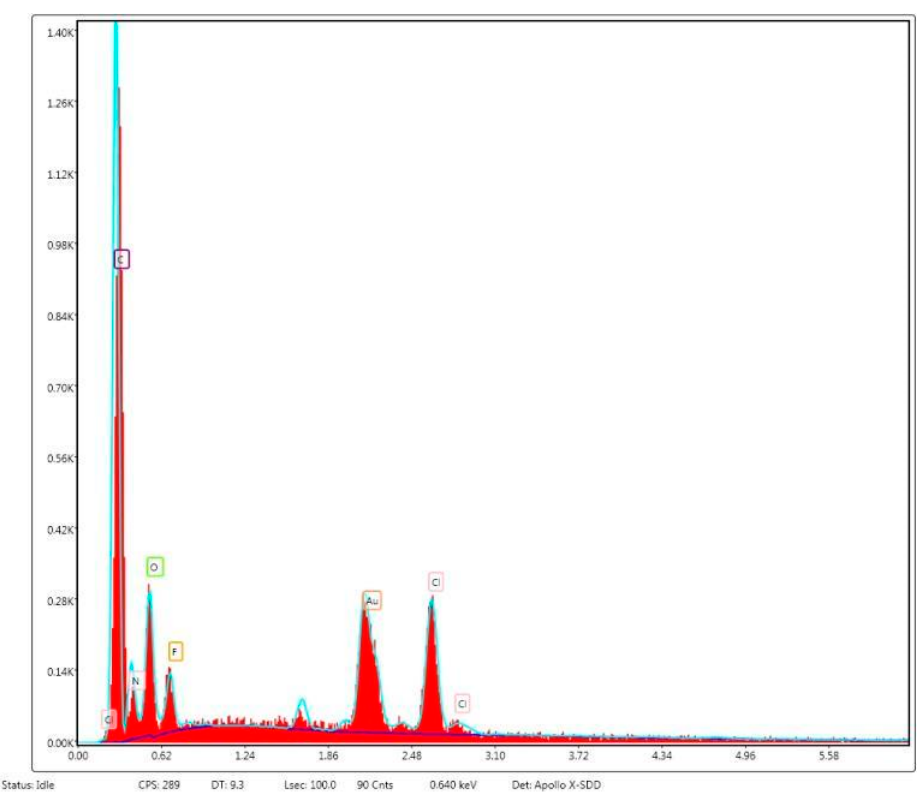
Figure 6. Selected EDX spectra of ciprofloxacin.